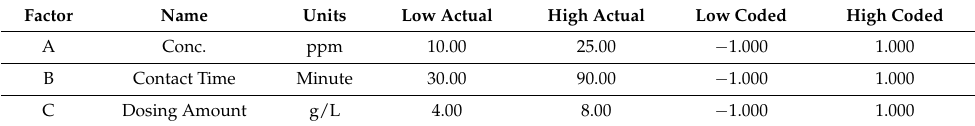
Table 8. Factors and Range of Design for CaO and CaCO 3 .